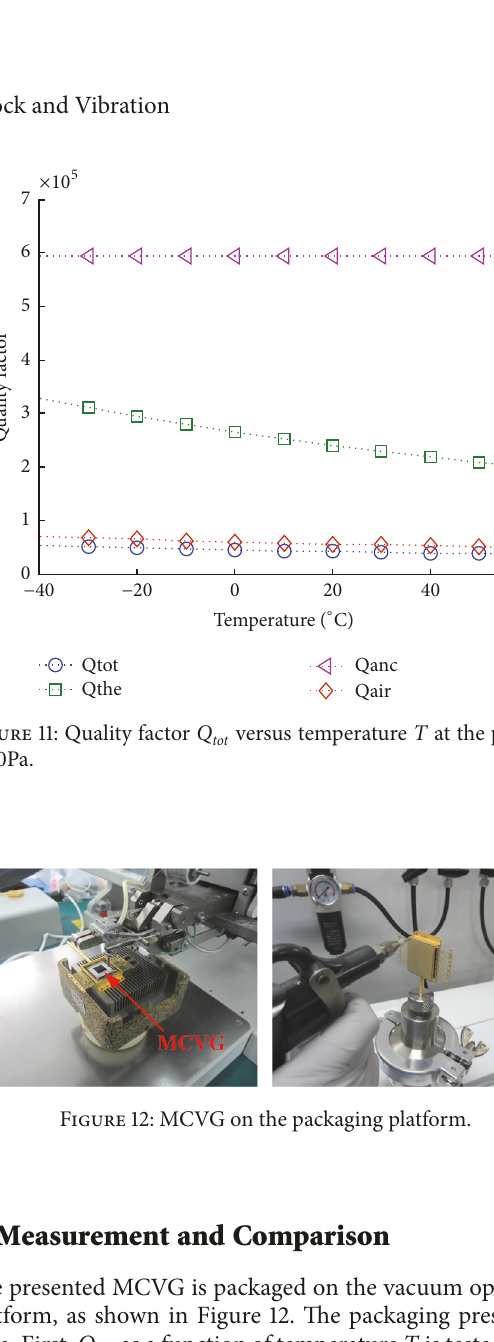
Figure 14: Measured quality factor Q ing at the pressure of